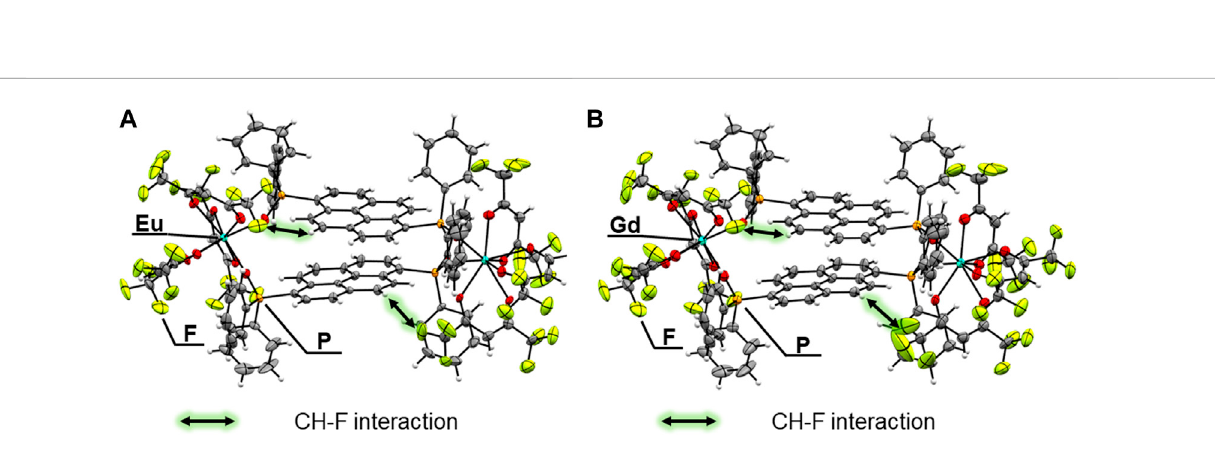
FIGURE 2 ORTEP drawings (ellipsoids set at 50% probability) of (A) [Eu 2 (hfa) 6 (PDDPO) 2 ] and (B) [Gd 2 (hfa) 6 (PDDPO) 2